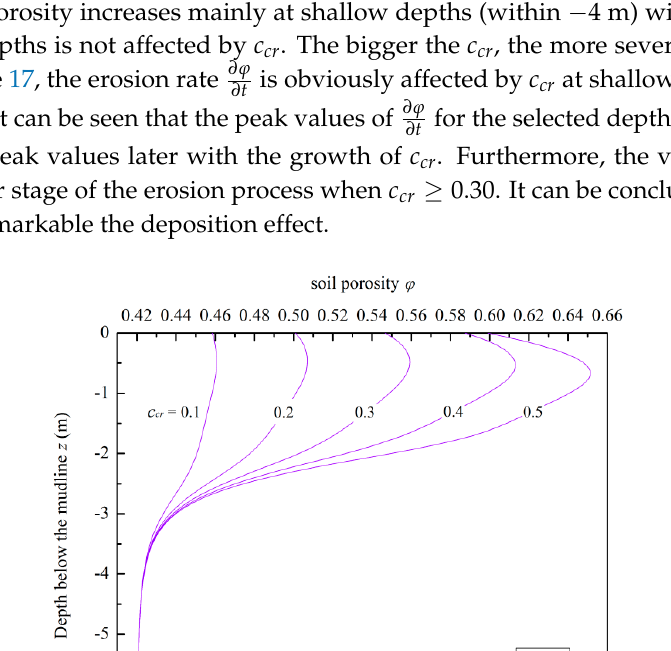
ϕ∂ ∂ t for different wave periods: ( a ) T = 5 s; ( b ) T = 10 s; ( c ) T = 15 s; ( d ) T = 20